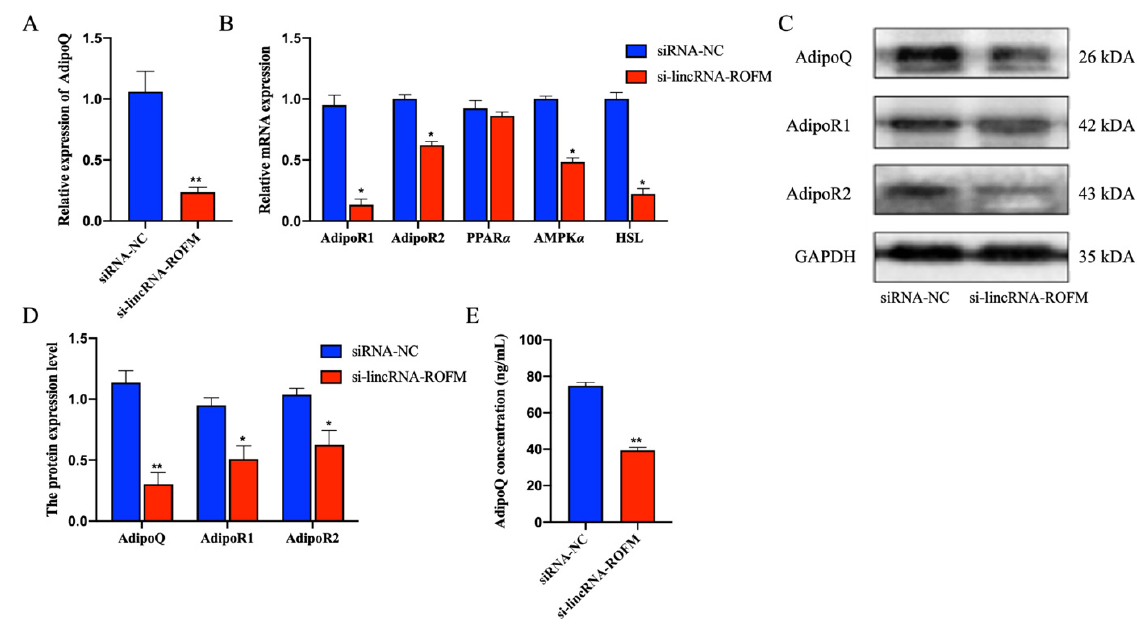
Figure 6. LincRNA-ROFM regulates the expression of AdipoQ . ( A ) mRNA expression level of AdipoQ in porcine preadipocytes transfected with LincRNA-ROFM siRNA after 6 days as detected by RT- qPCR assay. ( B ) mRNA expression levels of AdipoR1 , AdipoR2, PPAR α , AMPK α , and HSL in porcine preadipocytes transfected with LincRNA-ROFM siRNA after 6 days as detected by RT-qPCR assay. ( C ) Western blot of porcine preadipocytes transfected with LincRNA-ROFM siRNA after 6 days using antibodies against AdipoQ, AdipoR1, and AdipoR2 . ( D ) Histogram bar graph after Western blot signal quantification indicating the protein level of AdipoQ, AdipoR1, and AdipoR2 after transfection with porcine preadipocytes transfected with LincRNA-ROFM siRNA after 6 days. ( E ) The concentration of AdipoQ in porcine preadipocytes transfected with LincRNA-ROFM siRNA after 6 days as detected by ELISA assay. Data are presented as the mean ± SEM (n = 3) vs. siRNA-NC, * p < 0.05, ** p < 0.01.